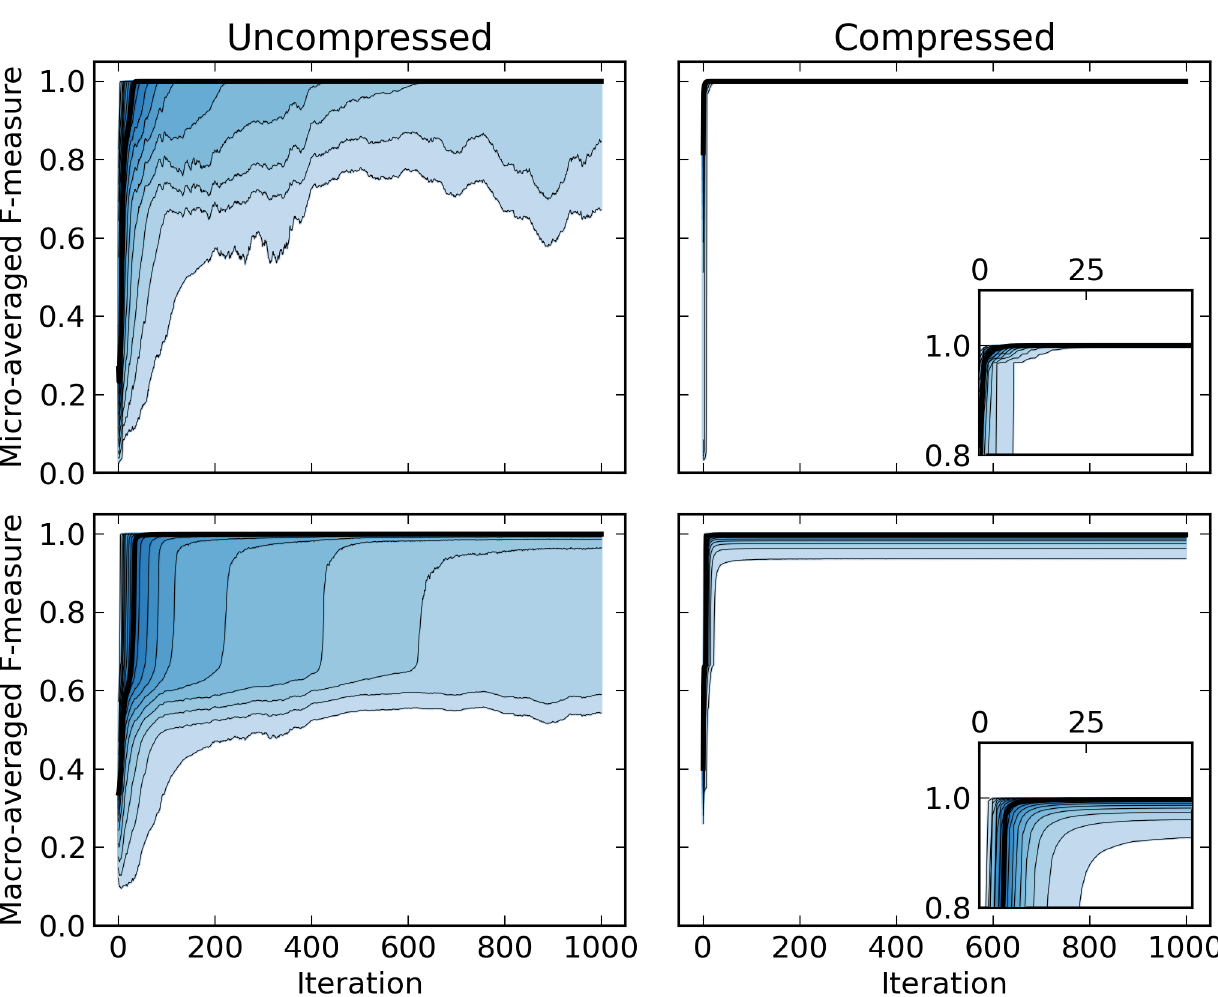
Fig 5. F-measures for simulation results. The median value (black) and quantile ranges (in 5% steps) of the micro- (top) and macro- averaged (bottom) F-measures ( F mi , F ma ) for uncompressed (left) and compressed (right) FBG inference, on the same 129,600 simulated data sets, using automatic priors. The x-axis represents the number of iterations alone, and does not reflect the additional speedup obtained through compression. Notice that the compressed HMM converges no later than 50 iterations (inset figures,